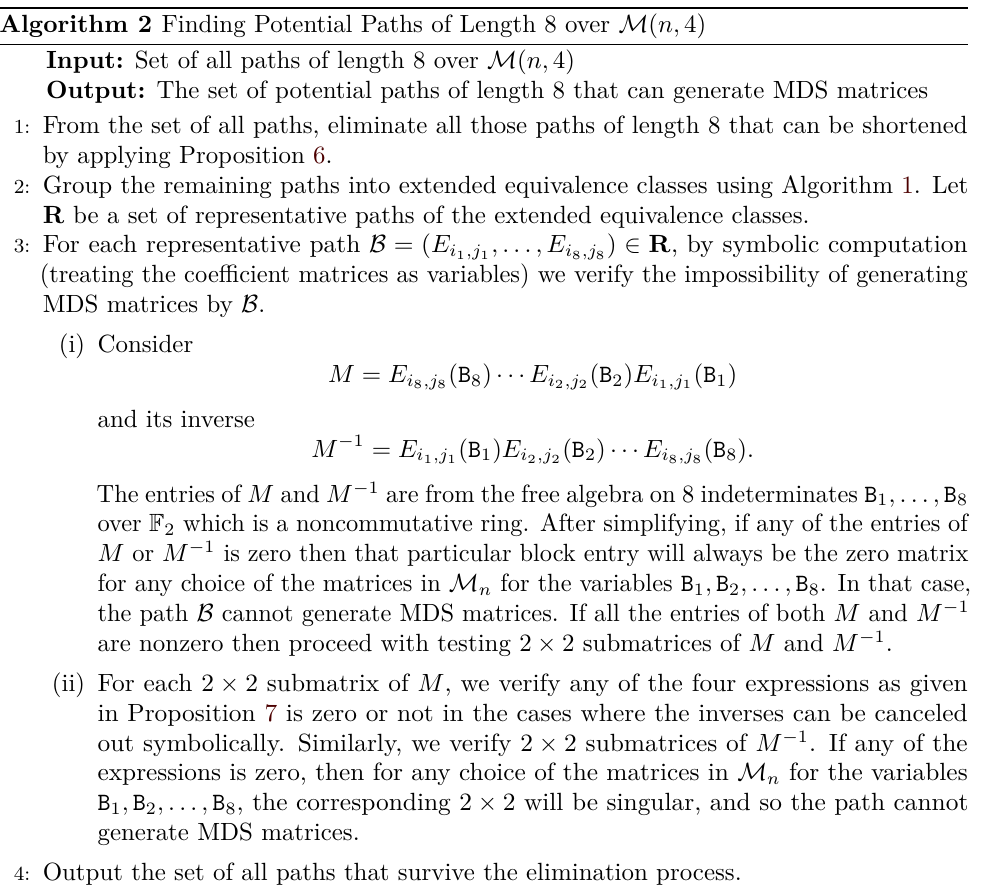
Fig 1: Representative Paths of the Extended Equivalence Classes over M ( n,